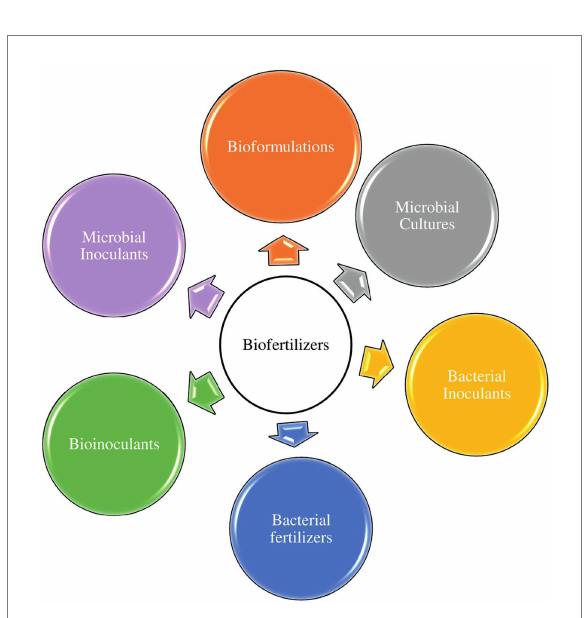
FIGURE 1 Terminologies used interchangeably with microbial